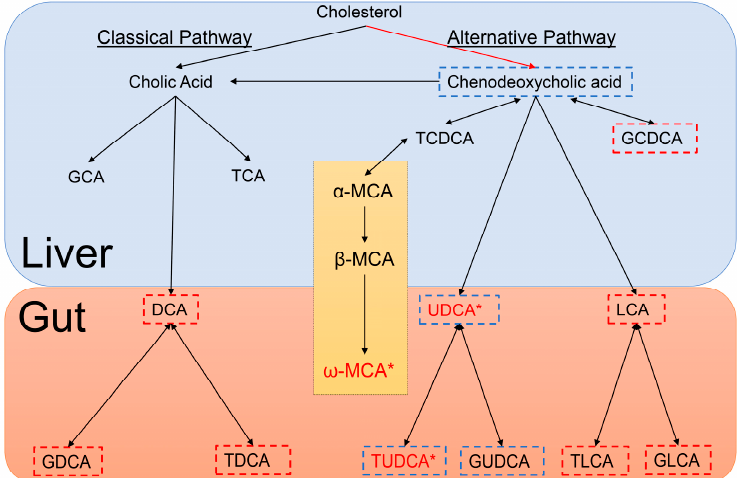
Figure 3. Depiction of Bile Acid Metabolism in the liver and gut of mice. Bile acids outlined in blue are neuroprotective, bile acids outlined in red are cytotoxic and those bile acids in red with an accompanying asterisk are statistically significantly different between HuMonomer- and PFF-injected mice. The section detailing Muricholic acid (MCA) only occurs in mice.